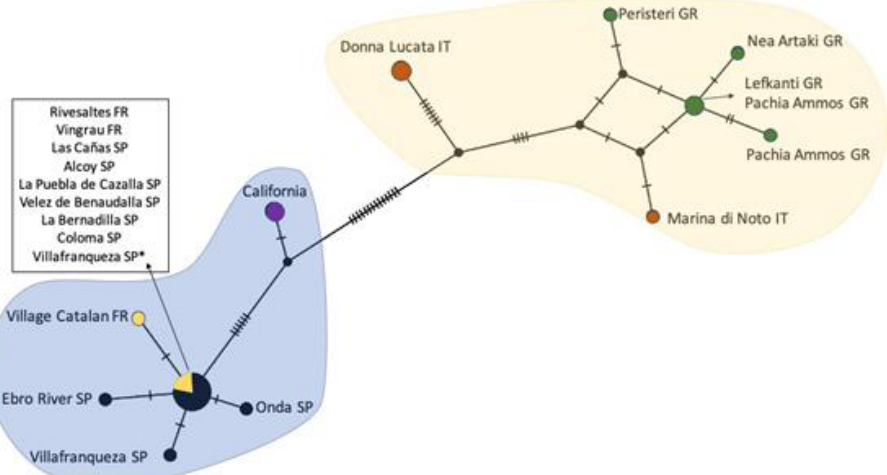
Figure 4. Haplotype network of Rhizaspidiotus donacis populations collected from California, France (FR), Greece (GR), Italy (IT), and Spain (SP) plotted with PopART and localities added manually. A 782 base pair sequence from scales collected at each location was compared via haplotype network analysis. Locations are indicated by the name of the collection location site. Villafranqueza SP* is the specimen from the population collected for release as part of the biological control program. Each hatch mark indicates a single nucleotide change. The colored shapes encompass sequences that display less than 2% genetic distance in Table S1. Each country where samples were collected is indicated by a unique color.